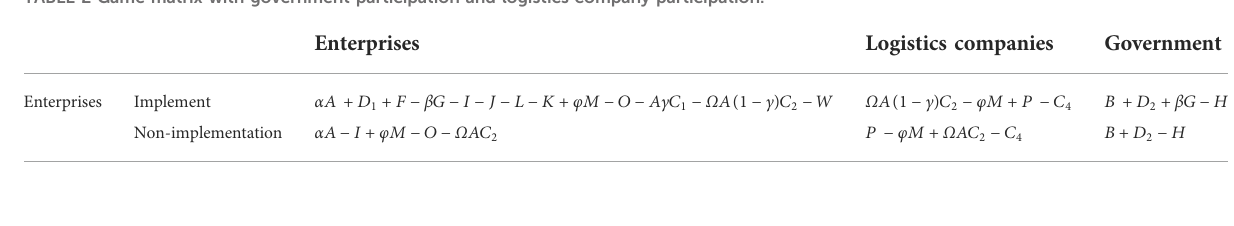
TABLE 2 Game matrix with government participation and logistics company participation.